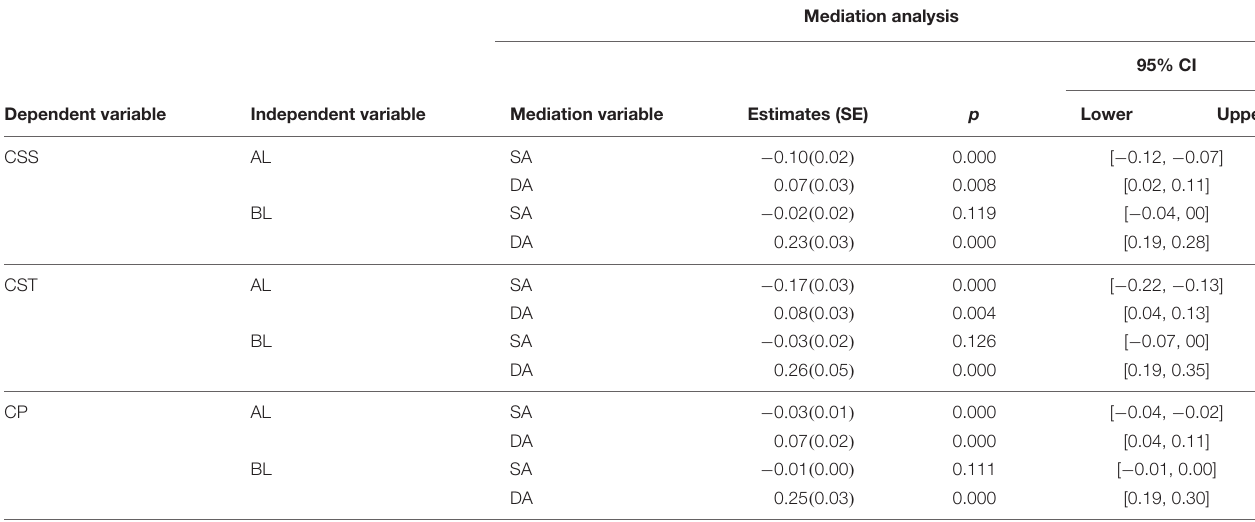
TABLE 2 | Mediation analysis of emotional labor on the effects of paternalistic leadership on teacher